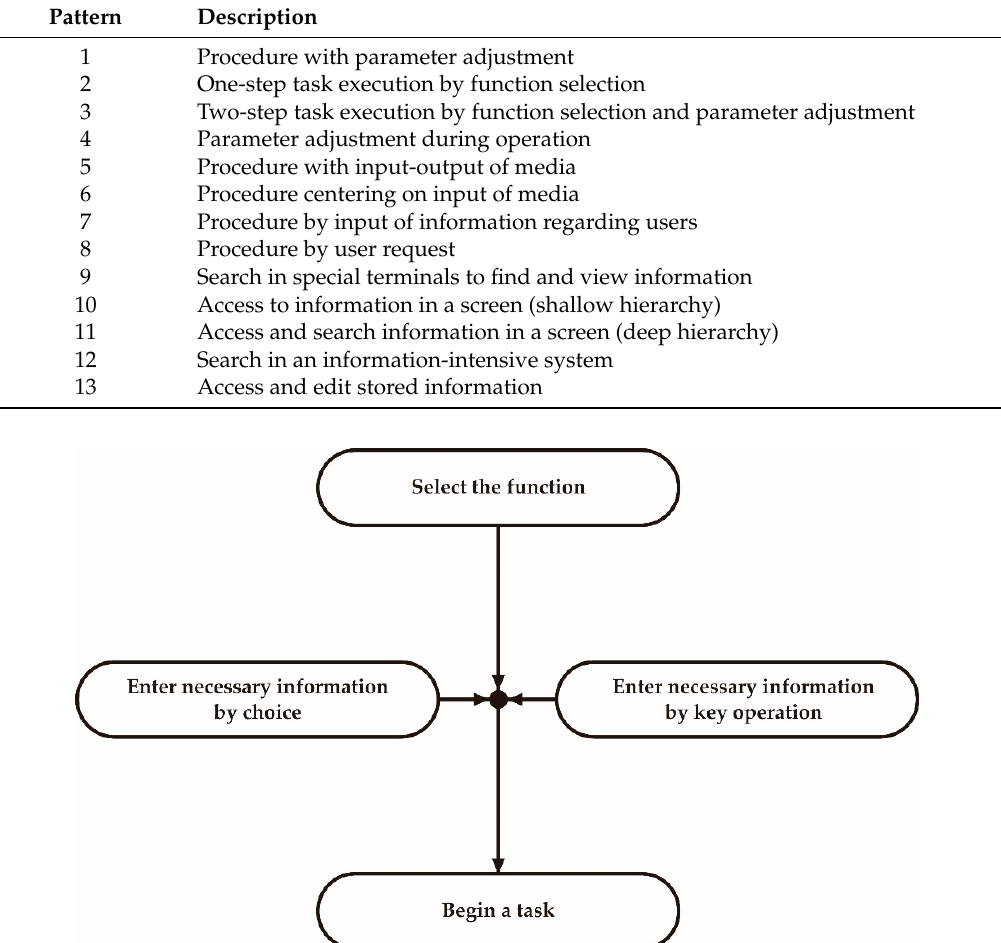
Table 1. List of flow design patterns.